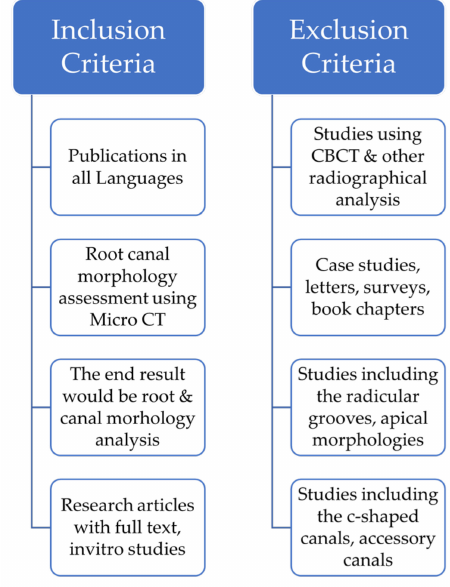
Figure 2. Inclusion and Exclusion